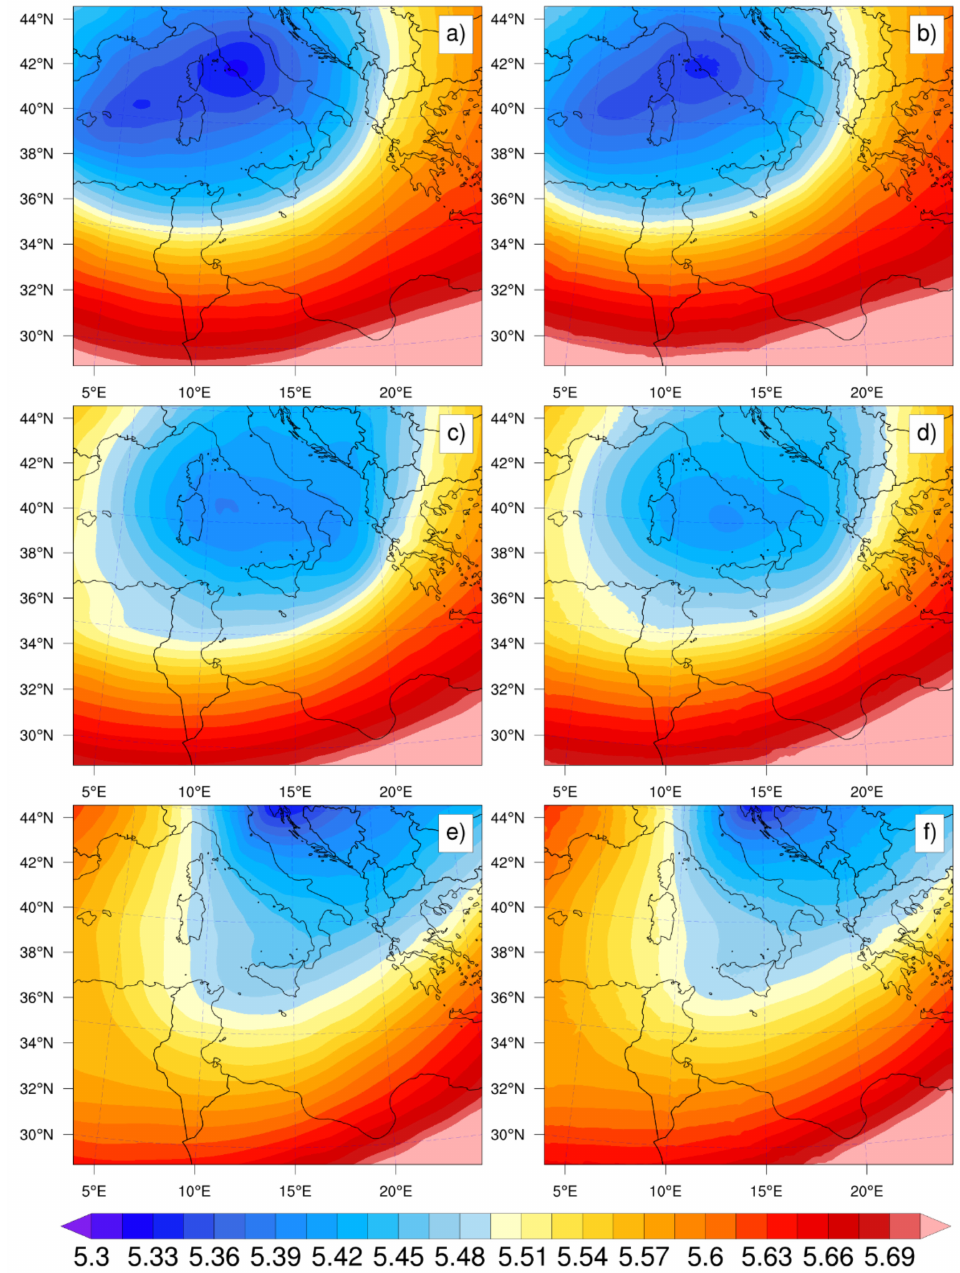
Figure 6. Geopotential at 500 hPa in km, panels ( a , c , e ) ERA5 reanalysis, panels ( b , d , f ) WRF-Chem. Top, middle, and bottom rows at 12:00 UTC on November 23, 24, and 25,